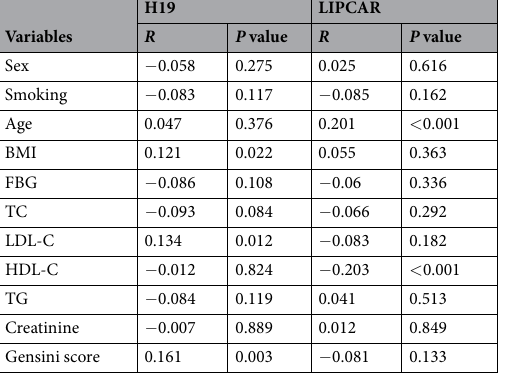
Table 2. Correlations between plasma H19 and LIPCAR with clinical characteristics. BMI, body mass index; FBG, fasting blood glucose; TC, total cholesterol; LDL-C, low-density lipoprotein cholesterol; HDL-C, high- density lipoprotein cholesterol; TG, triglyceride.